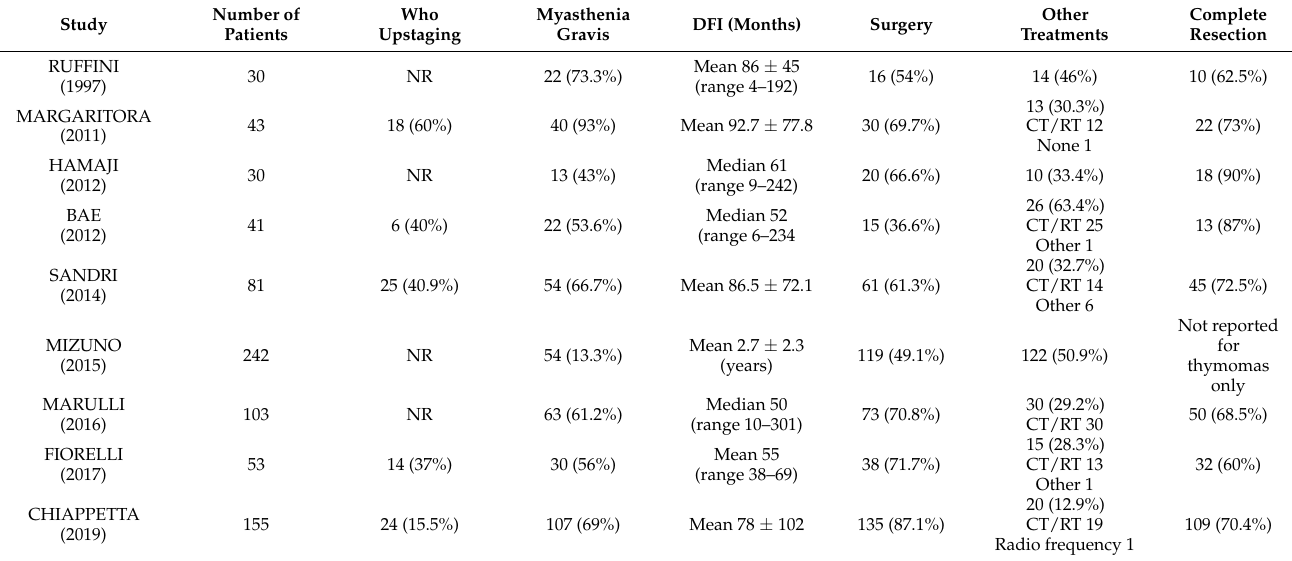
Table 1. Studies’ characteristics.